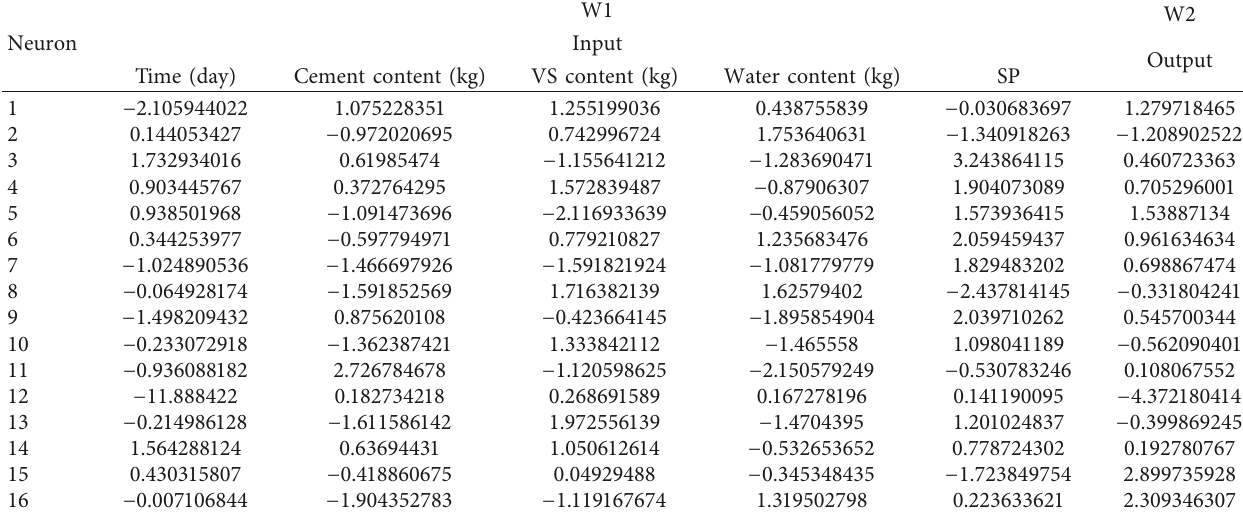
Table 5: Weight matrix and weights between input and hidden layers (W1) and between hidden and output layers (W2) for the ANN1 model.